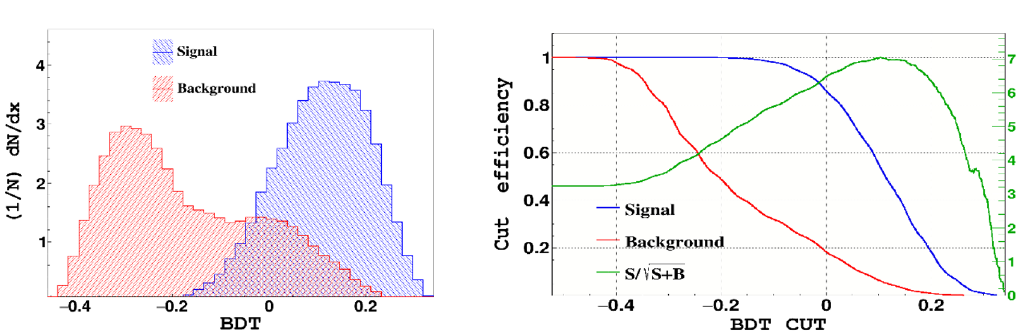
Figure 4 . Left: the distribution of the Boosted Decision Tree response to the signal (blue) and to the background (red), superimposed. Right: cut efficiency that maximizes the BDT cut. For a cut value greater than 0.104 one can get S √ = 7 . 04 σ with number of signal events = 2043 and S + B background events = 82212 after the BDT cuts. The cut efficiency for the signal is 0.57 and for